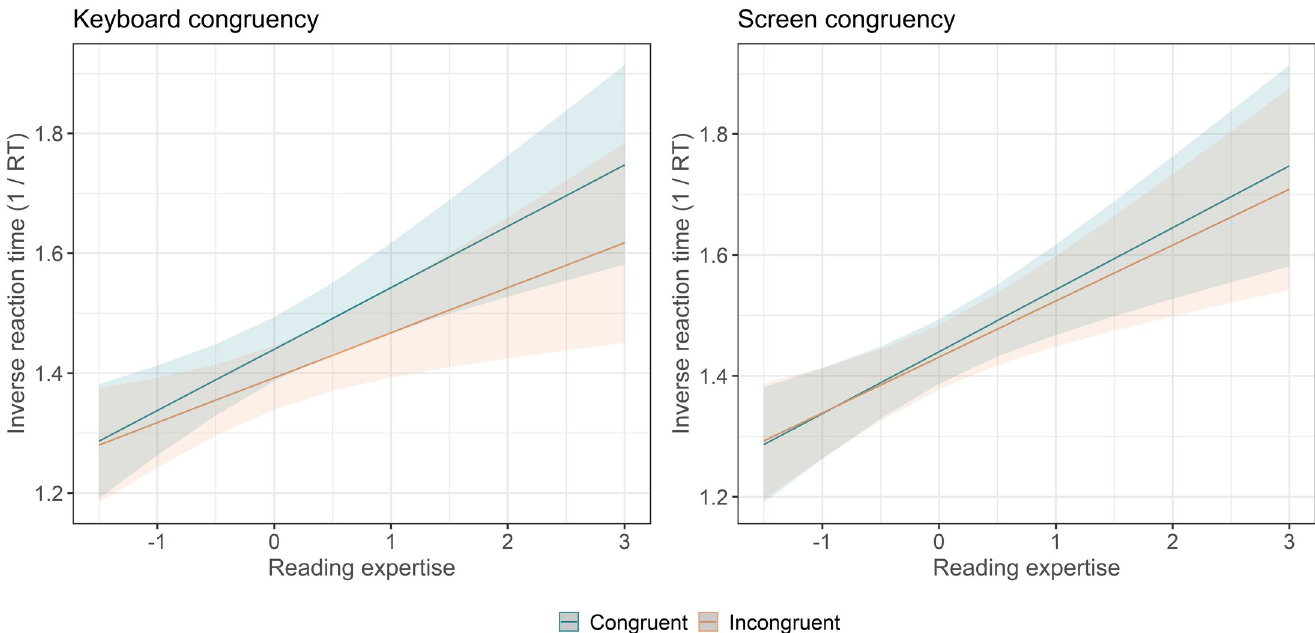
Fig 4. Estimated values from the mixed models for inverse reaction times showing the interaction between reading expertise (i.e., standardised SLS score) and space-time congruencies (keyboard and screen congruency). The greater the reading experience, the greater the congruency effect, in particular in the keyboard conditions (left